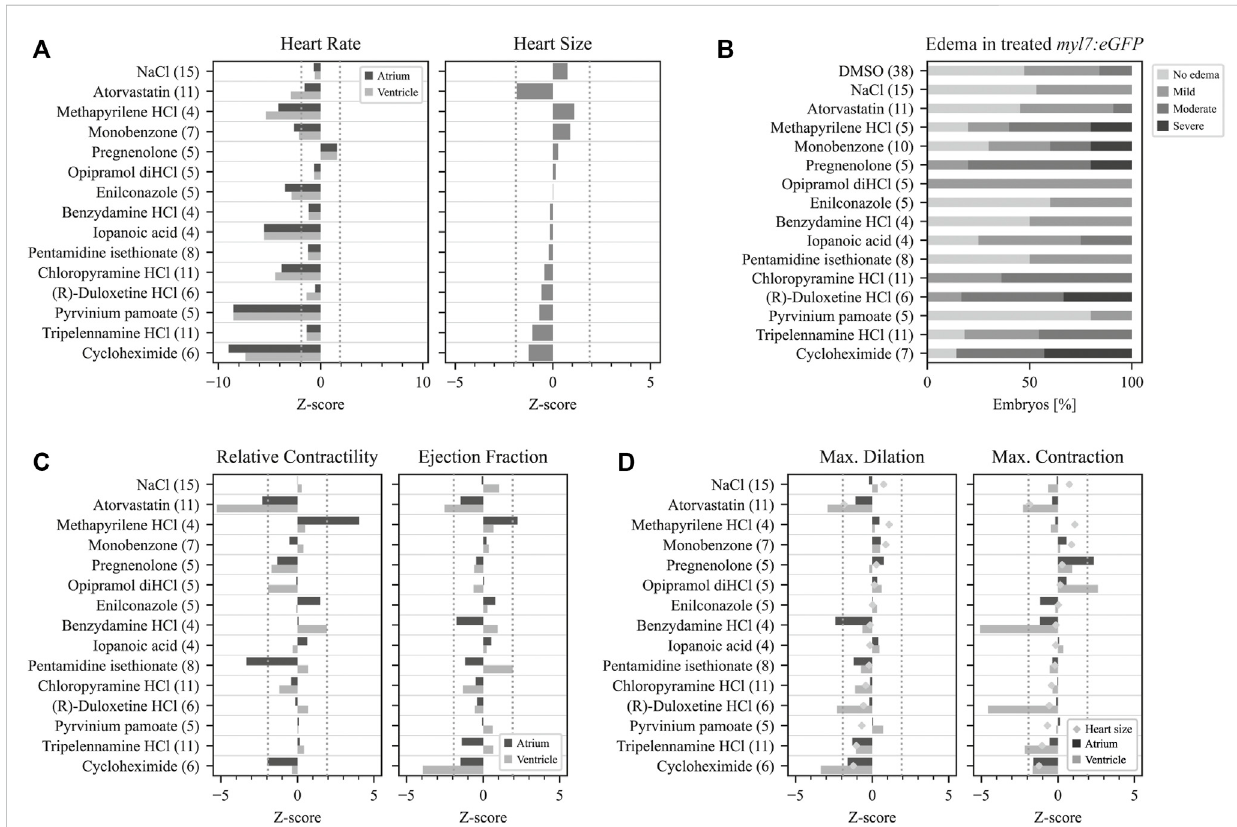
FIGURE 4 Quantitative data analysis with pyHeart4Fish . Analysis of treated fi sh with pyHeart4Fish revealed multiple functional heart phenotypes. (A) The left graph presents the detected heart rate derived from the fast fourier transformation (FFT). The right graph displays the approximate heart size in µm 2 . (B) Percentual data on the severity of manually assessed pericardial edema in treated Tg( myl7:eGPF ) twu34/+ zebra fi sh. (C) The relative contractility derived from percentual size changes of each heart chamber (left graph). Approximate ejection fraction determined by chamber volume changes (right graph). (D) Meanmax.heartchambersize(dilation)ispresentedontheleft,whilethemeanmin.heartchambersize(max.contraction)isdisplayedonthe right. The number of fi sh analyzed is shown in brackets after the treatment condition. Dotted gray lines indicate z-scores of ±1.96 and statistical signi fi cance with an alpha error of